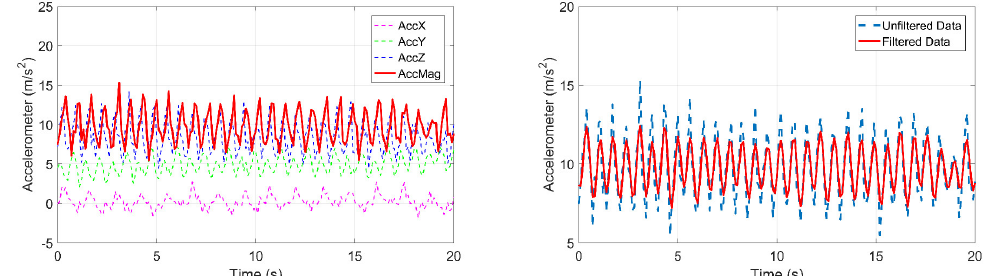
Figure 2. ( left side ) The cyclic pattern of triaxial and total accelerations during a walking process; ( right side ) comparison between the total accelerations and total accelerations after filtering.